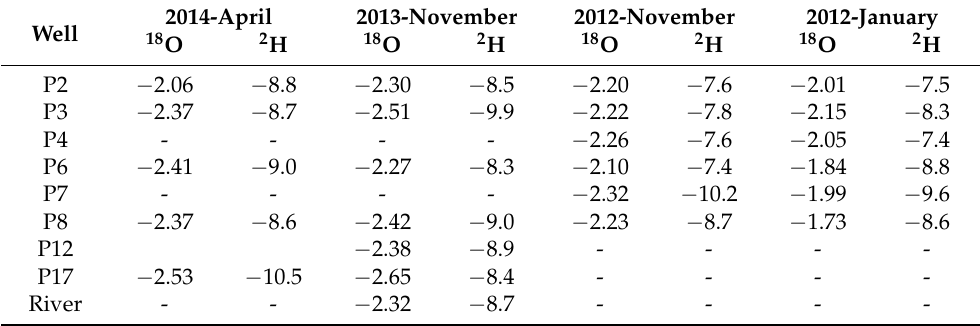
Table 2. Compilation of Table 1 18 O and 2 H isotope data from the waters of the Manglaralto hydrogeological system obtained in campaigns from 2012 to 2014 [39].